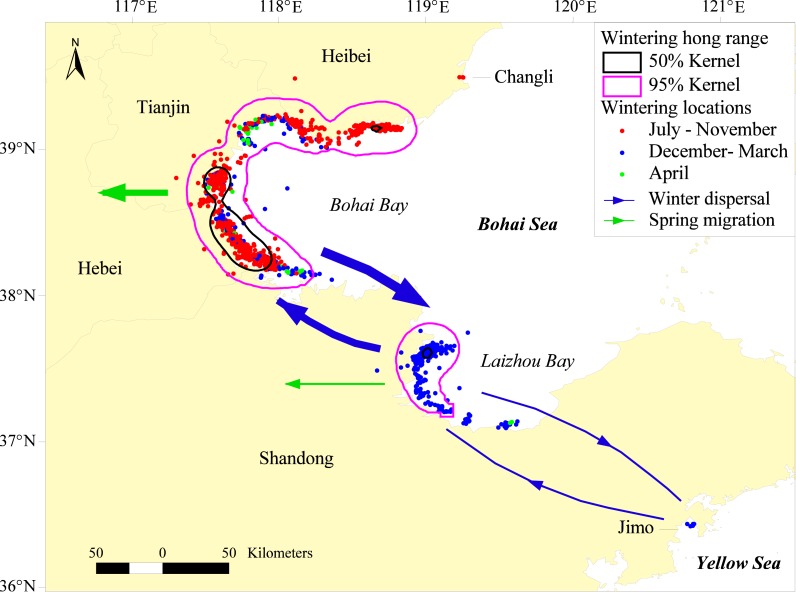
Wintering home range and wintering dispersal of satellite-tracked Relict Gulls on Bohai Bay and Laizhou Bay from 2008–2012.The size of the arrows roughly indicates the number of dispersal gulls.